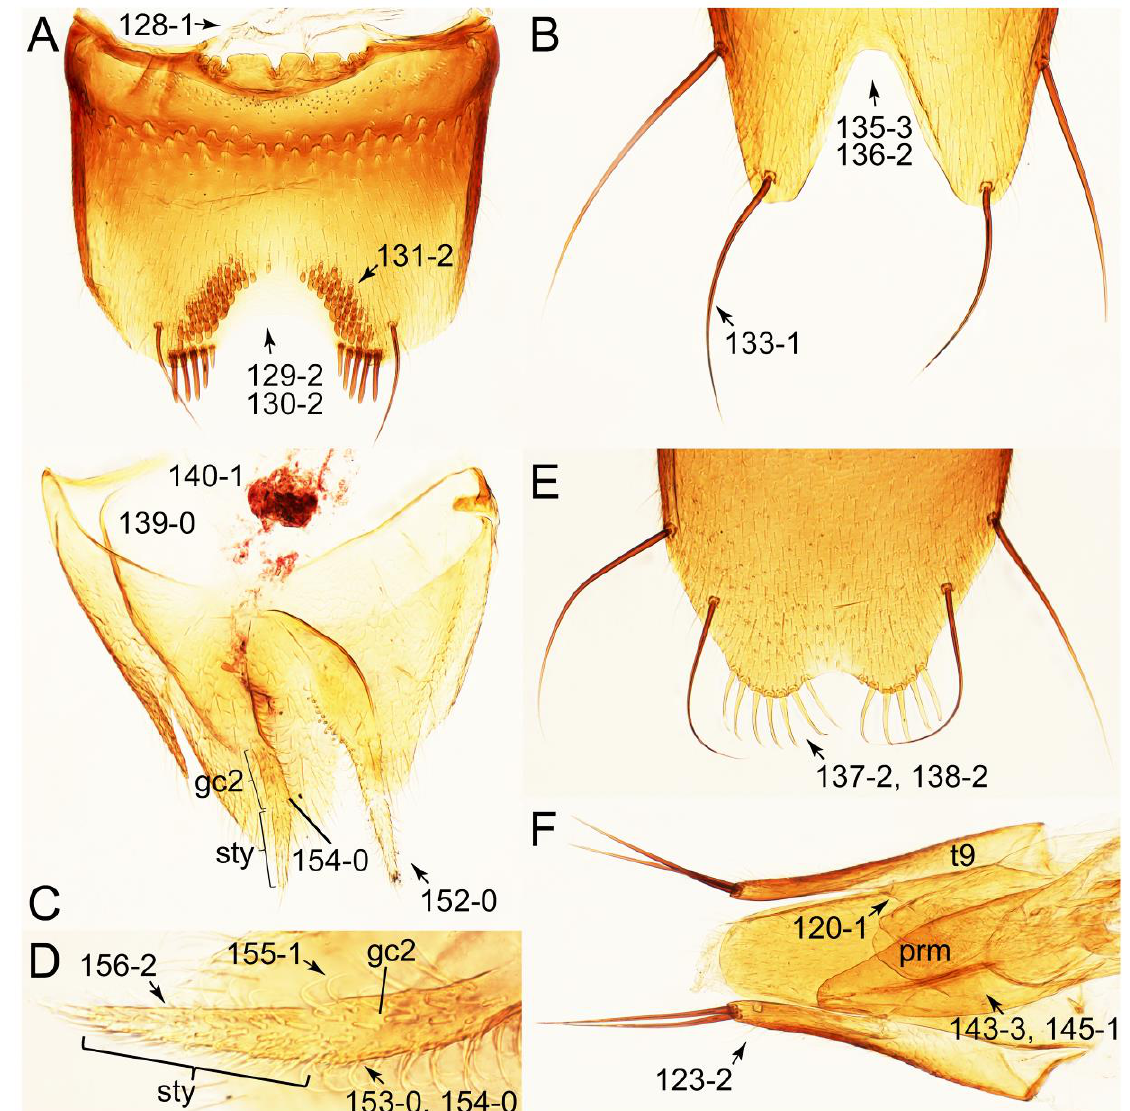
Figure 47. Photographs of body parts of Deropini ( Derops ), enlarged: Derops longicornis . ( A ) male sternite VII, ventral view. ( B ) male sternite VIII, ventral view. ( C ) female genital segments, dorsal view. ( D ) female gonocoxite II and gonostylus, dorsal view. ( E ) female sternite VIII, ventral view. ( F ) male tergites IX and X with aedeagus, ventral view. Abbreviations: gc2, gonocoxite II; prm, paramere; sty, gonostylus; t9, tergite IX. Characters and character states (format X-X) are indicated on each